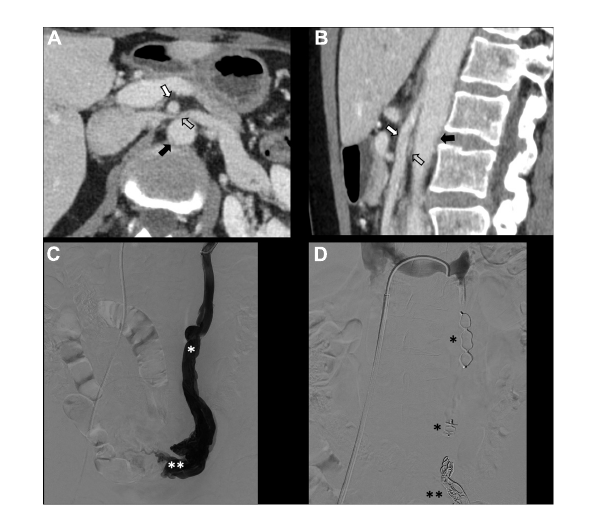
FIGURE3 Type IIb pelvic varices in a 54 yo female due to nutcracker syndrome. (A,B) Computed tomography (CT) phlebography shows the left renal vein (open arrow) compressed by the mesenteric artery (white arrow) and aorta (black arrow). (C,D) Conventional phlebography shows dilated left ovarian vein (single white asterisk) with left-sided pelvic varices (double white asterisks), treated with multiple plugs (single black asterisk) and coils (double black